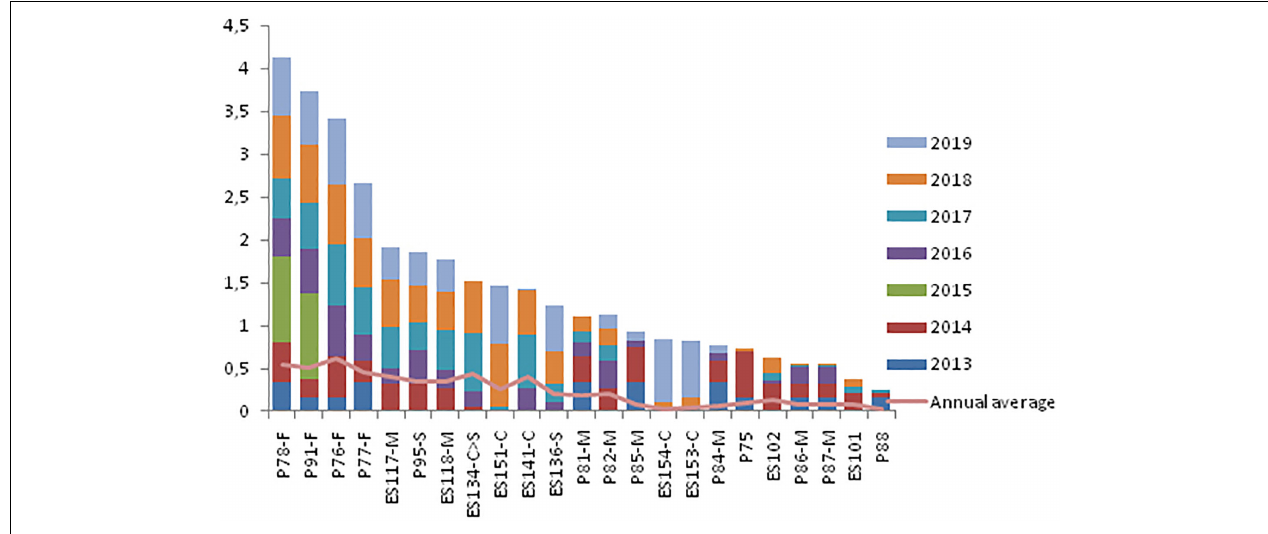
FIGURE 9 | Cumulative annual residency levels of resident individuals in the El Morro community during the period 2013–2019. Each color represents 1 year. F = adult female, M = adult male, S = subadult, C = calf. The light red line indicates the annual average of the level of residence of each individual.